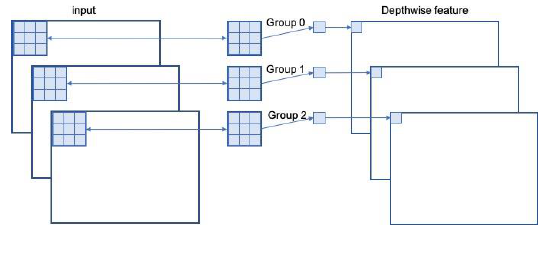
Figure 10. Depthwise convolution